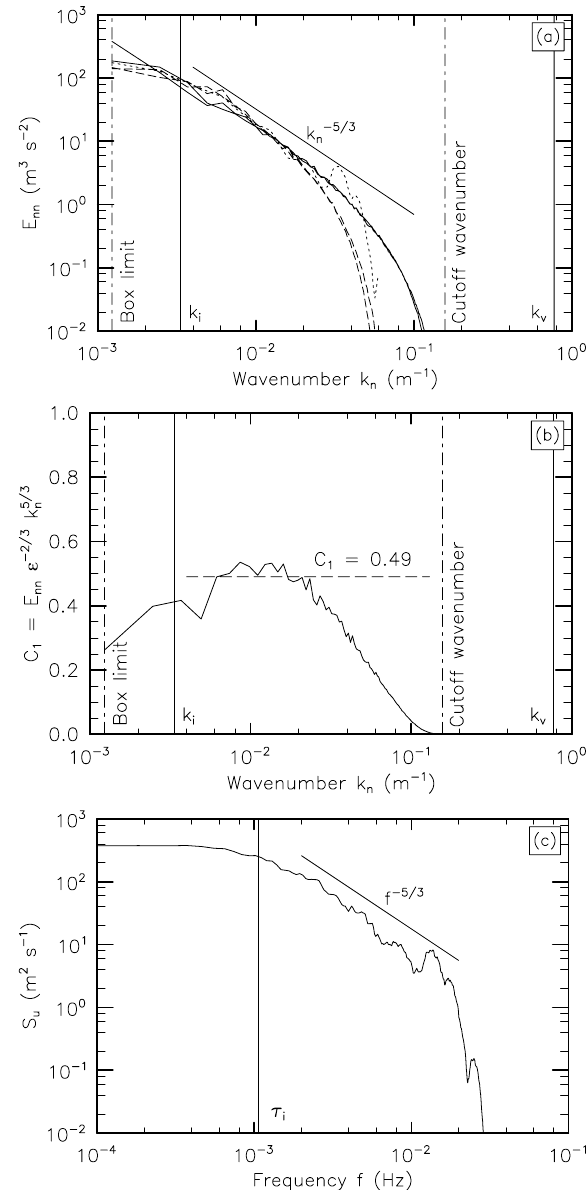
Fig. 5. (a) One-dimensional longitudinal velocity spectra E ii (k i ) of e u and e v computed for the 256 3 resolution run (–) at 15:00EST and averaged over the range 0.4 <z/z i < 0.6. The spectra computed for a 128 3 resolution run (---) are superimposed for comparison. The dotted line ( · · · ) represents the spectrum deduced from the fre- quency velocity spectrum S u (f ) of e u , displayed in plot (c) and com- puted for the 256 3 resolution run, from 12:00EST to 15:00EST at z =500m in the center of the (x,y) plane. (b) Constant C 1 in Eq. (15) computed for the 256 3 resolution run and averaged for the e u and e v spectra as a function of k i